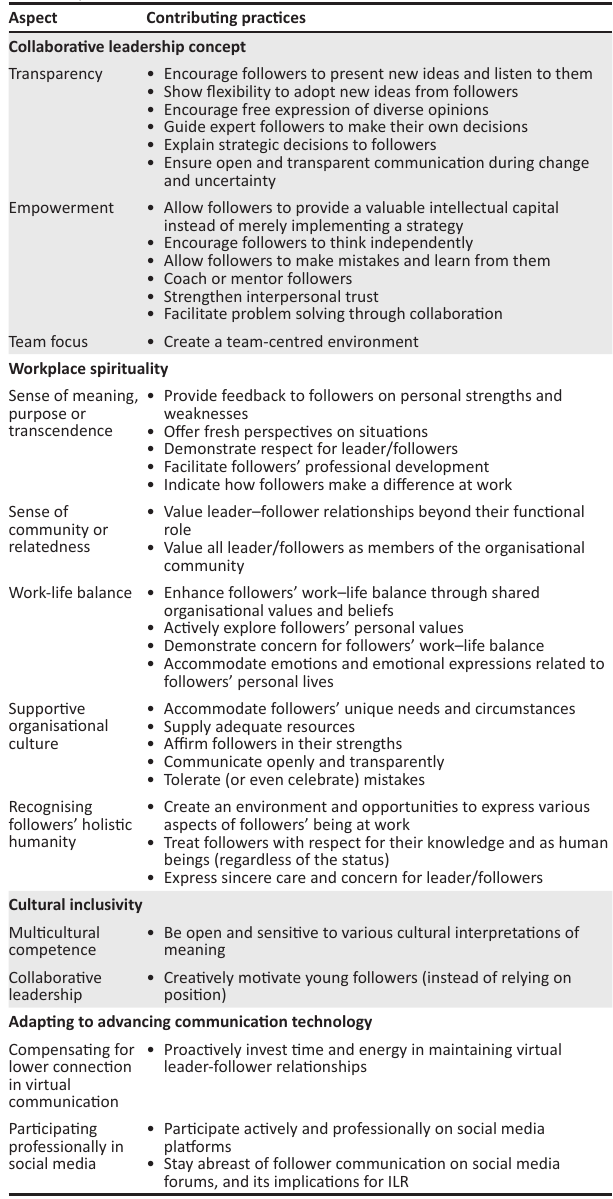
TABLE 3: An organisational climate that supports constructive interpersonal leadership